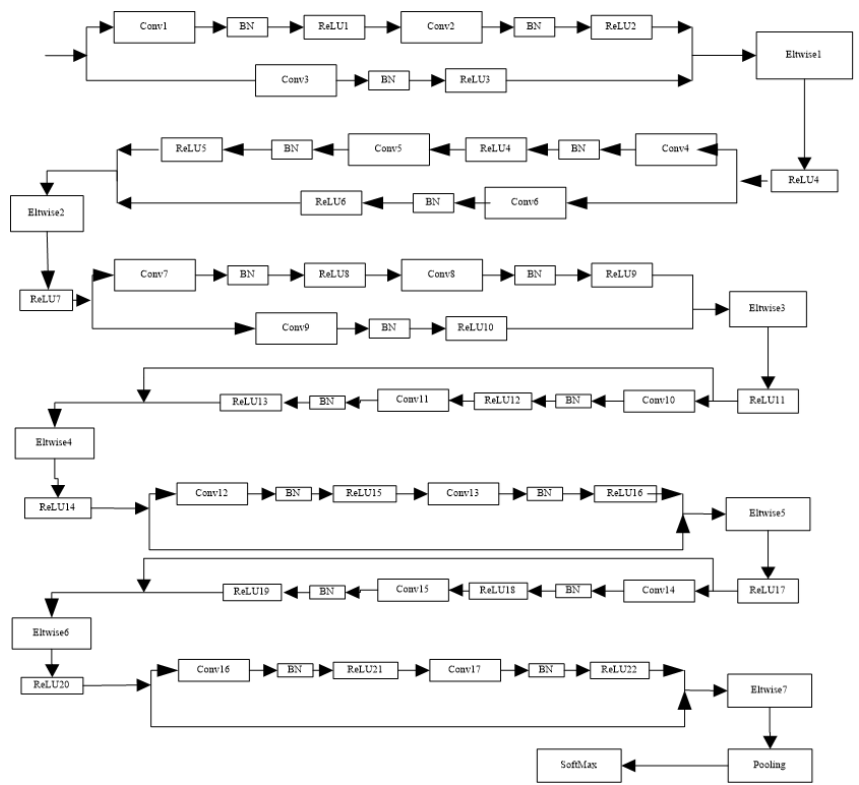
Fig. 5 The overall structure of the improved